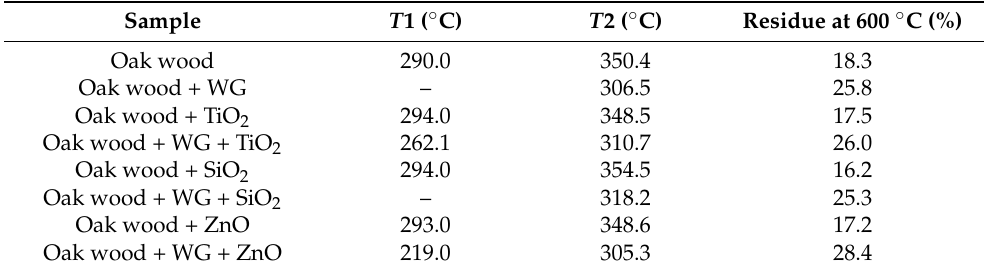
Table 1. Thermal degradation temperatures and residue at 600 ◦ C from TG and DTG analyses.